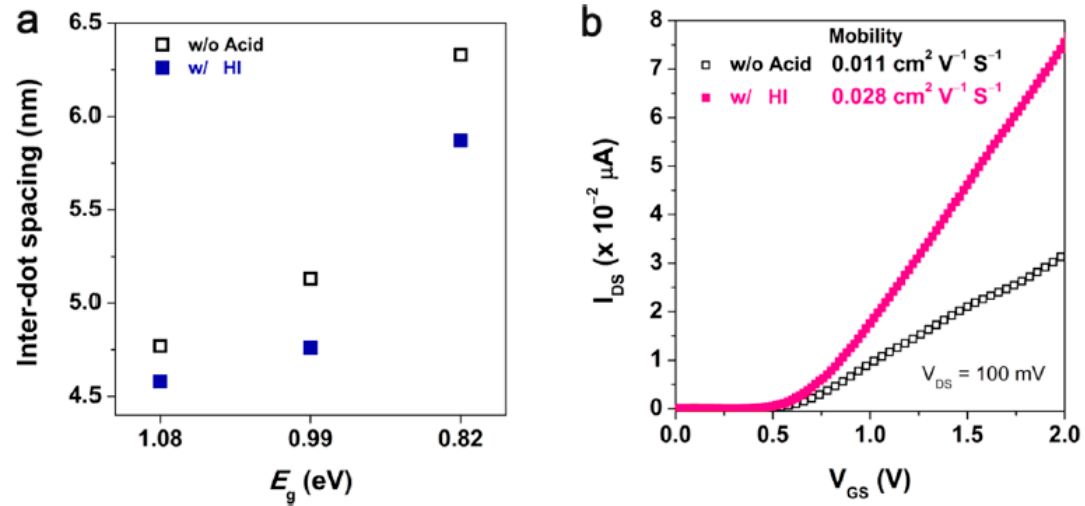
Figure 8. Film geometry and charge transfer characteristics of infrared (IR) PbS CQD films treated with hydroiodic acid (HI) during solution-phase ligand exchange process. ( a ) Interdot spacing of PbS CQD film according to HI treatment. ( b ) Mobility of PbS CQD films characterized by field-effect transistor (FET) measurements. Reprinted from reference [63]. Copyright 2018 American Chemical Society.